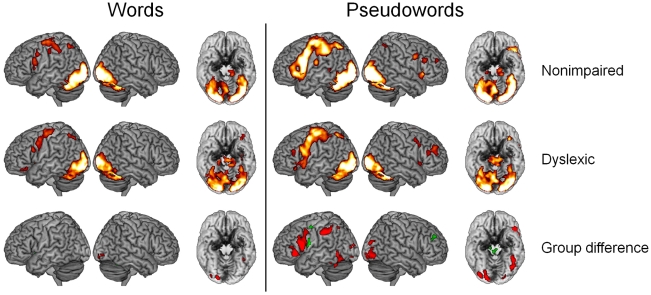
Whole brain activation.Brain renders of the within- and between group whole-brain results showing dyslexic under- (red) and overactivation (green) in response to words vs. fixation and pseudowords vs. fixation, respectively.